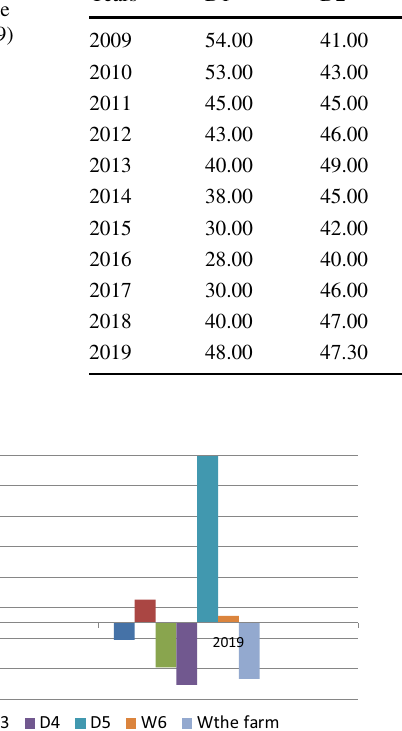
Table 7 Magnesium (mg/l) values of water points in the Mougheul area (2009–2019)